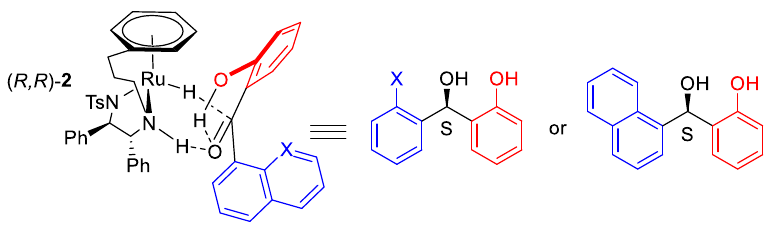
Figure 11. Involvement of H-bond in reduction mechanism.